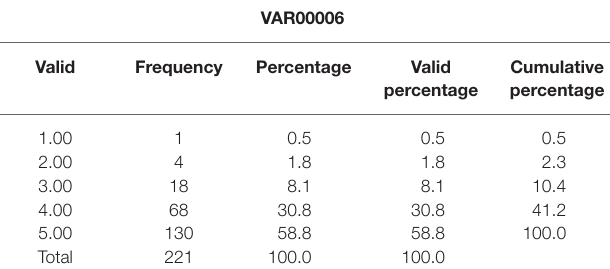
TABLE 6 | Activity has motivated me because it has enabled me to contribute my creative